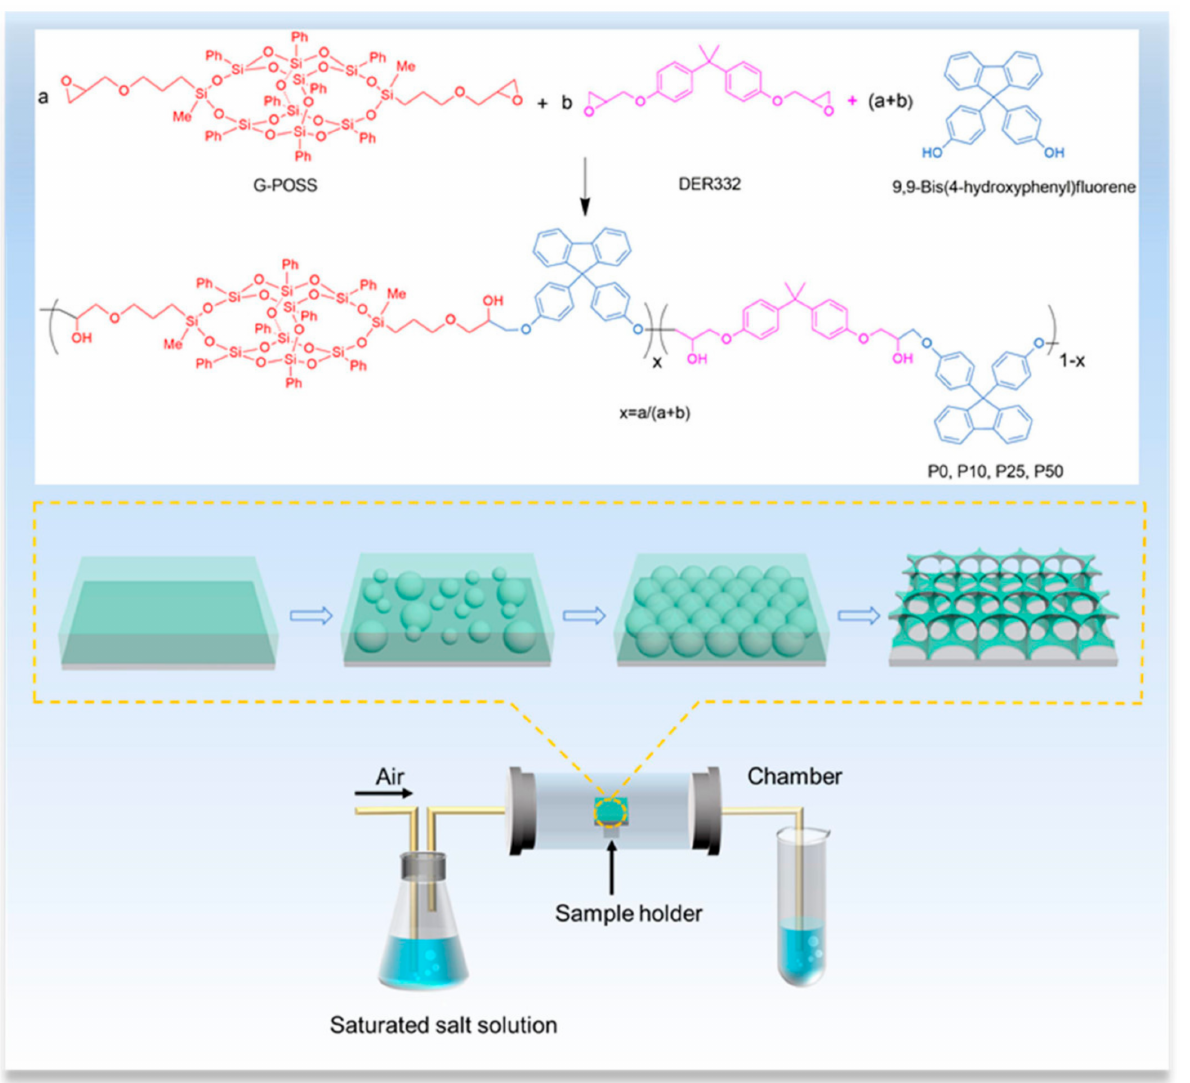
Figure 7. The idea of synthesizing linear double-decker silsesquioxane hybrids P0, P10, P25, and P50 and customized apparatus for hierarchical porous film fabrication [Reprinted with permission from Ref. [52]. Copyright 2023 American Chemical